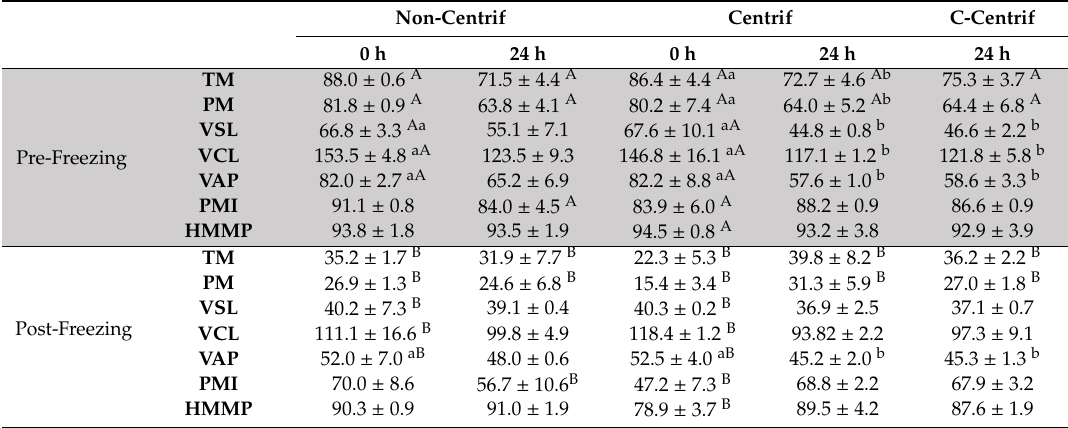
Table 2. Pre-freeze and post-thaw parameters of the epididymal semen obtained from freshly castrated donkeys ( n = 4 pairs). Each epididymal pair was submitted to retrograde flushing with a semen freezing egg yolk-based extender (EY), or a cooling extender based on sodium caseinate cholesterol-loaded cyclodextrin (SC). Thereafter, the semen extended in EY was frozen immediately after recovery ( Non-Centrif-0 h ) or cooled for 24 h and then frozen ( Non-Centrif-24 h ). The semen extended in SC was cushion-centrifuged, resuspended in EY and then frozen ( Centrif-0 h ); or cooled for 24 h before being frozen ( Centrif-24 h ); or cushion-centrifuged, re-extended with SC, and then cooled for 24 h, re-centrifuged and extended in EY and then frozen ( C-Centrif-24 h ). Samples were assessed pre-freezing and post-freezing . Data are expressed as mean ±